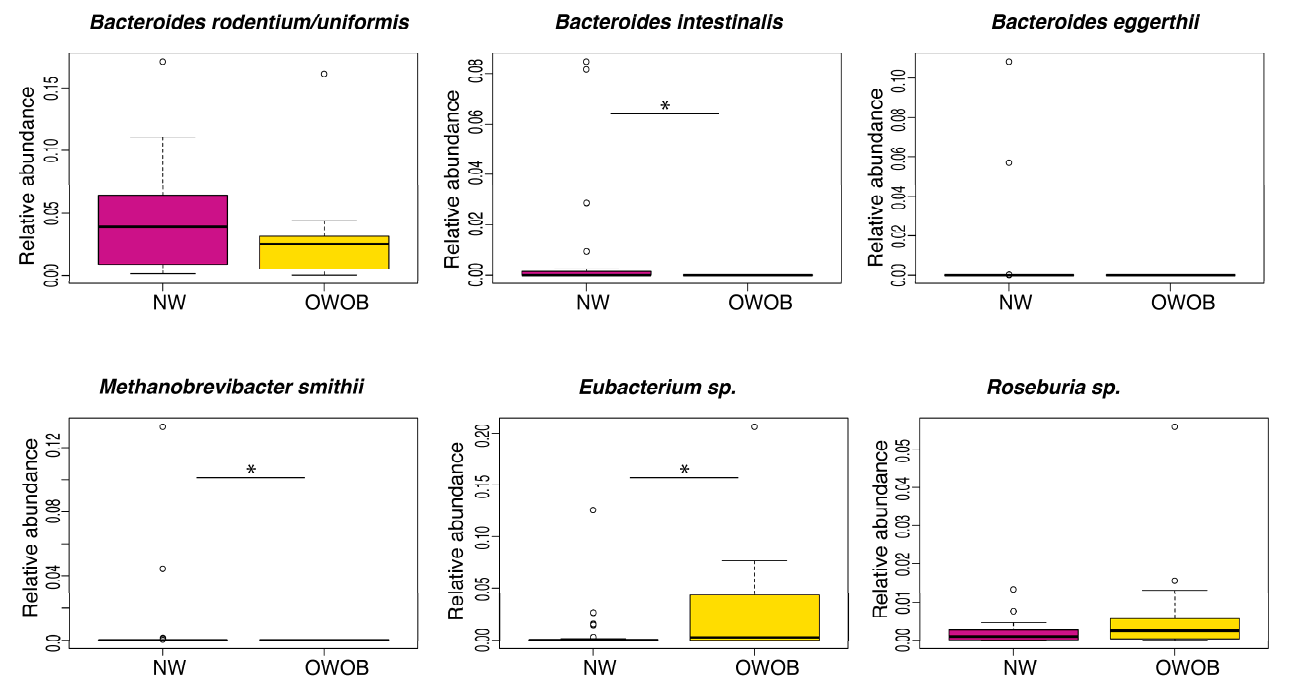
Figure 3. Relative abundance of taxa that showed difference in normal-weight (NW, magenta) group compared to overweight-obese (OWOB, yellow). Pairwise comparisons using Wilcoxon Rank-Sum Test adjusted by FDR: Bacteroides rodentium/uniformis p -value = 0.055, Bacteroides intestinalis p -value = 0.0012, Bacteroides eggerthii p -value = 0.073, Methanobrevibacter smithii p -value = 0.042, Eubacterium sp. CAG:180 p -value = 0.044, Roseburia species p -value = 0.098. *: p <= 0.05